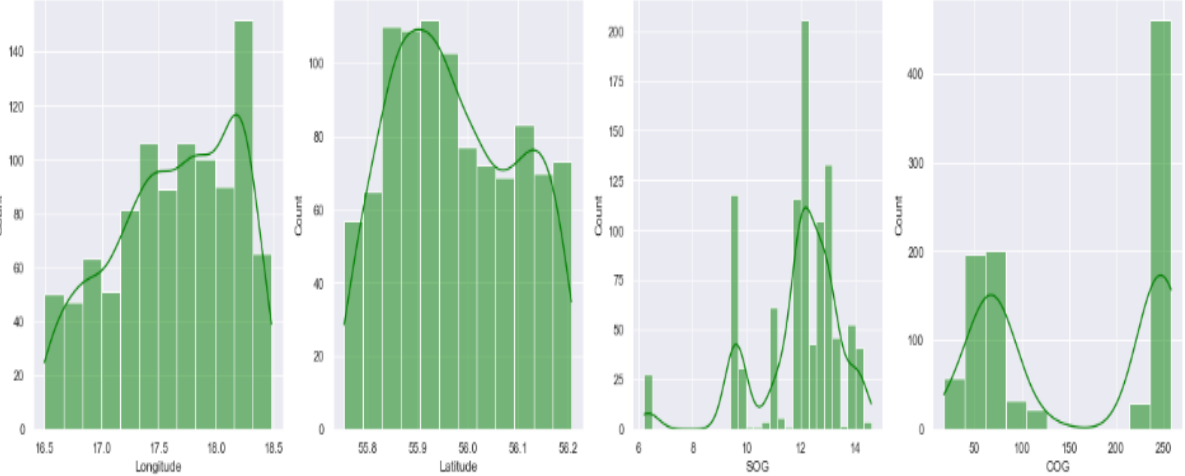
Figure 10. Distribution of dataset based on various